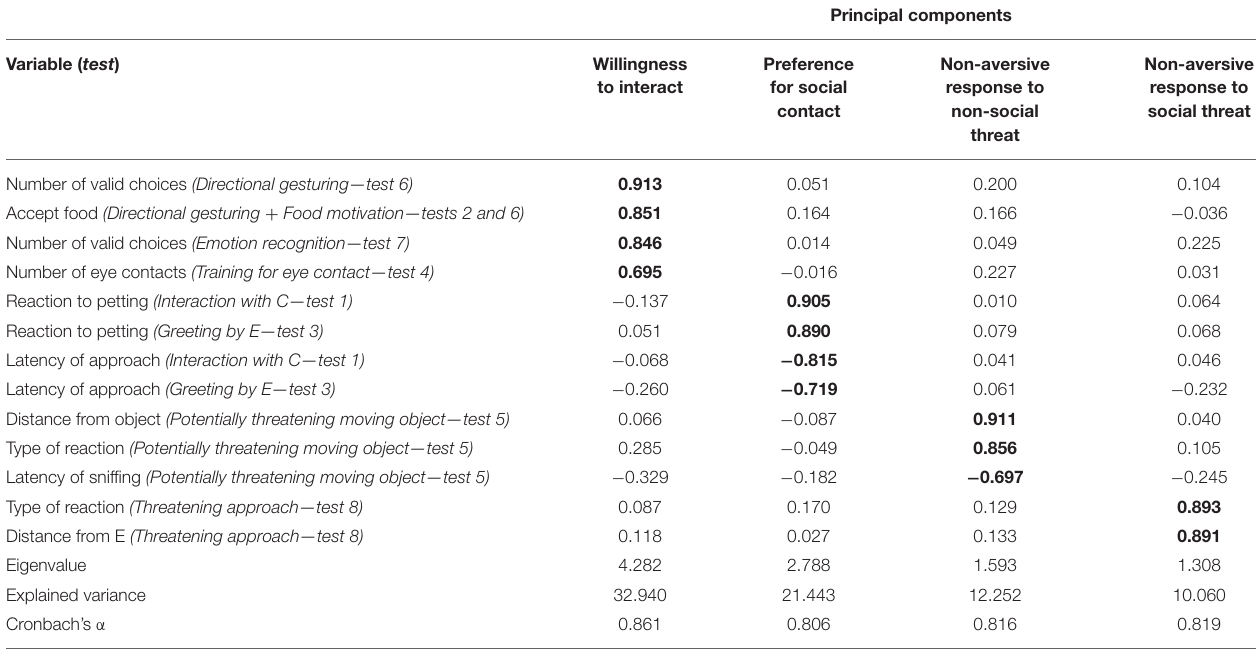
TABLE 2 | Results of the principal component